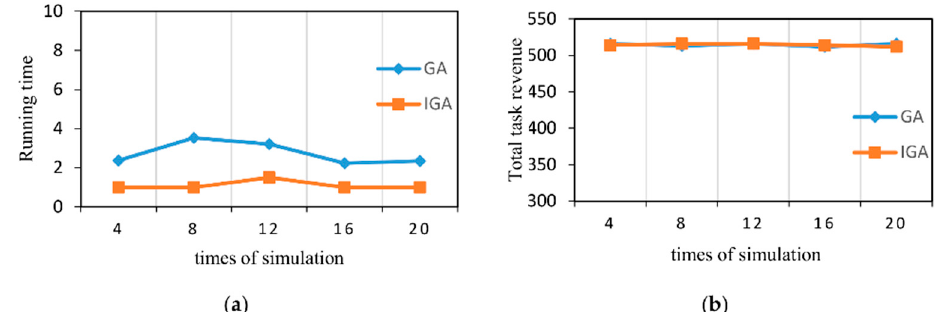
Figure 10. The result of Experiment 1. ( a ) The running time of Experiment 1 and ( b ) the task revenue of Experiment 3.